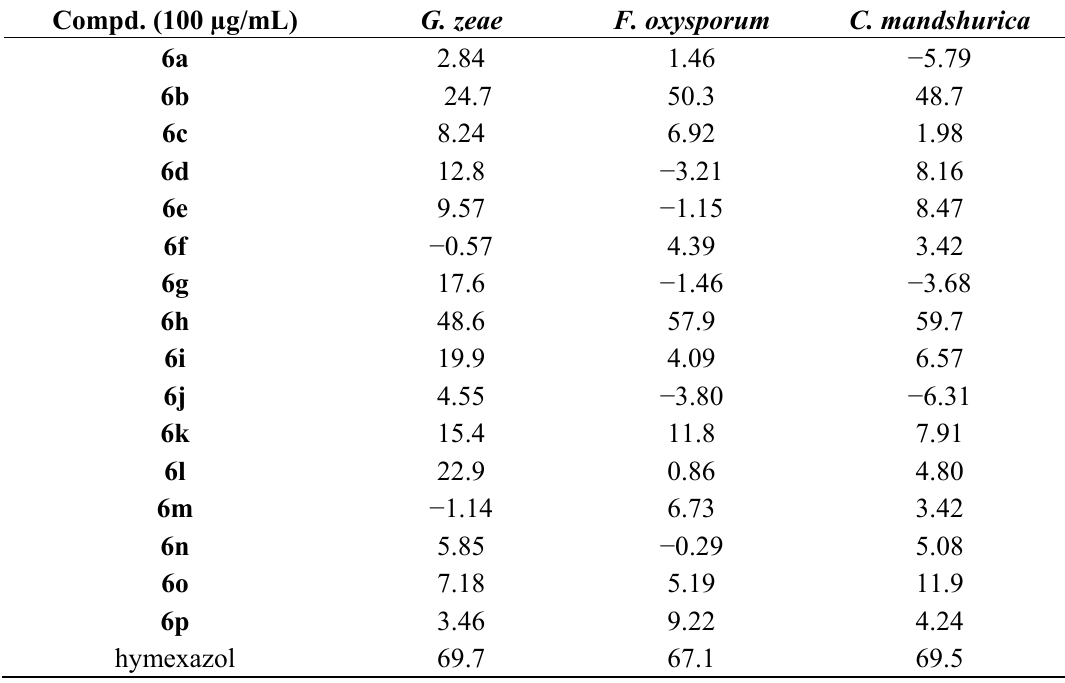
Table 2. Inhibition effects of pyrazole acyl thiourea derivatives 6 on phytopathogenic fungi. Compd. (100